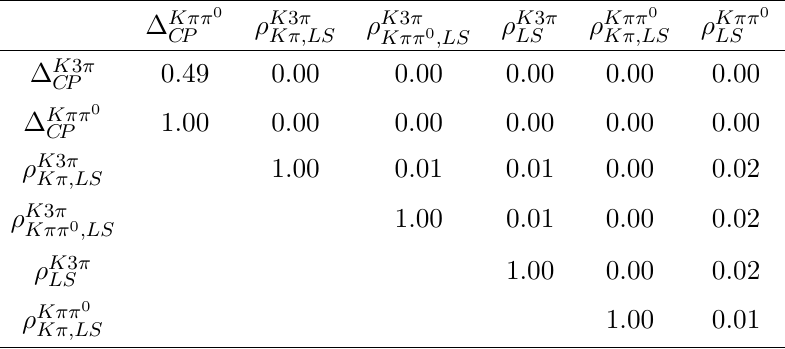
Table 14 . Correlation matrix for the observables in the global analysis.